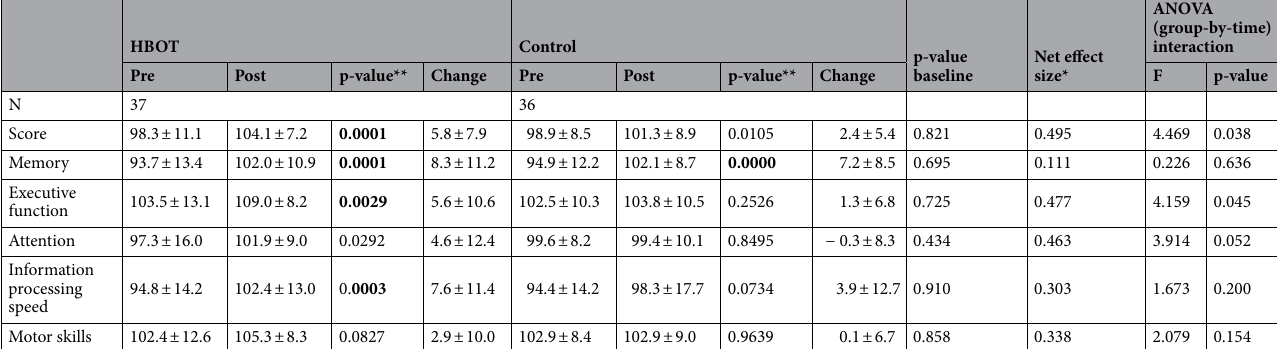
Table 2. Neurocognitive performance changes. Data are presented as mean ± SD; Bold, significant after Bonferroni correction; * Cohen’s d net effect size; ** pre-post treatment/ sham P-value. The follow up assessments were performed 1–3 weeks after the last treatment session.